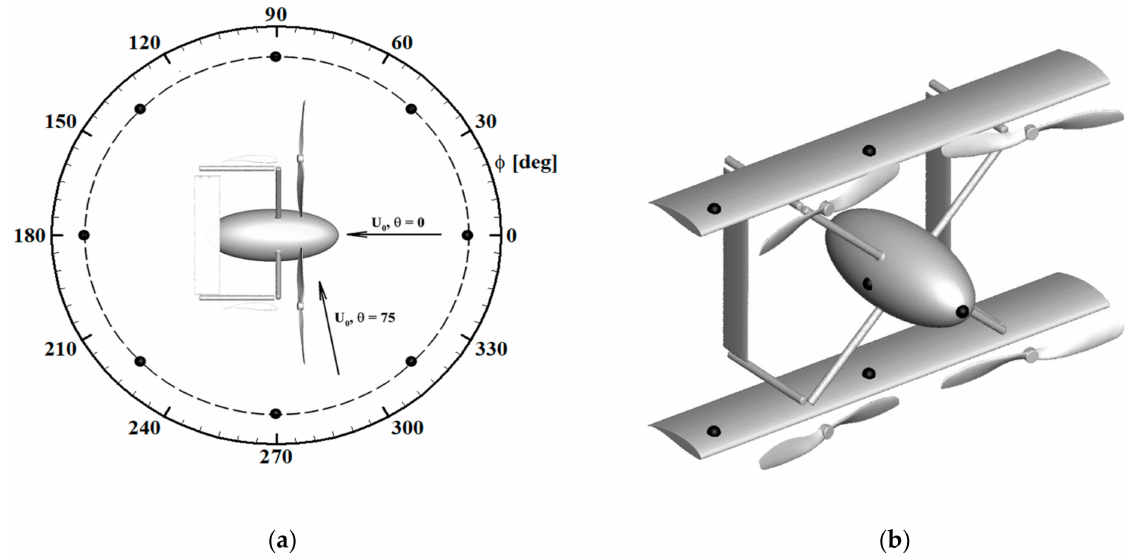
Figure 2. Microphone positions: ( a ) circular array; ( b ) on the CRC-3